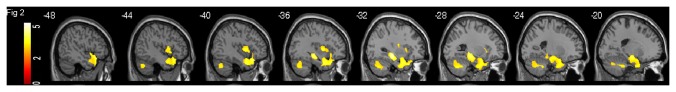
Grey matter correlates of CF.Brain regions where voxel-based GM volumes are positively correlated with CF in 344 participants aged 70-90 years, superimposed on the sagittal slices of the brain template. The slices are at 4 mm intervals between and including -48 mm and -20 mm. The colour bar represents the t score ranging from 0 to 5.5; and yellow indicates a higher t score than red.